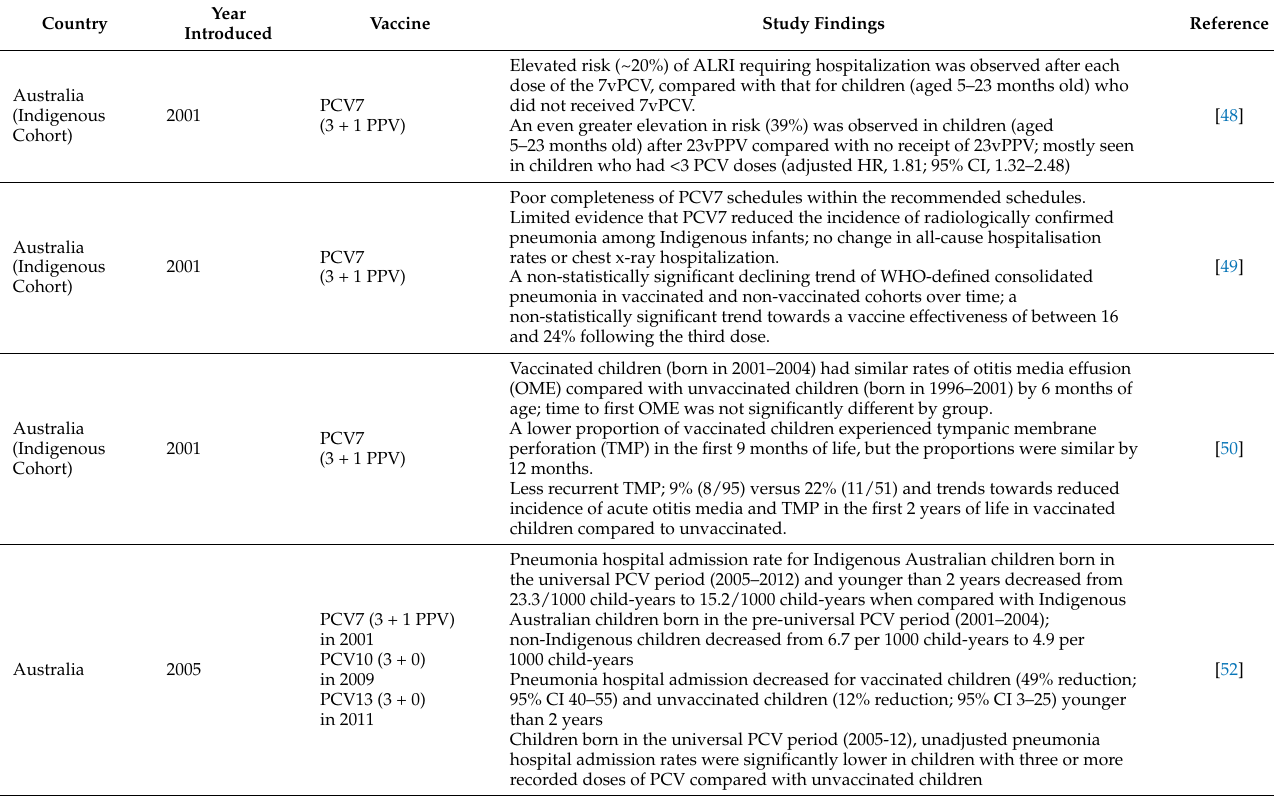
Table 4. Pneumococcal vaccine impact